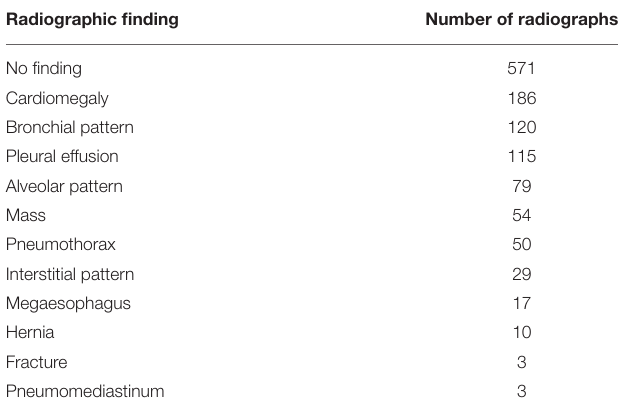
TABLE 1 | Summary of the radiographic findings for the LL